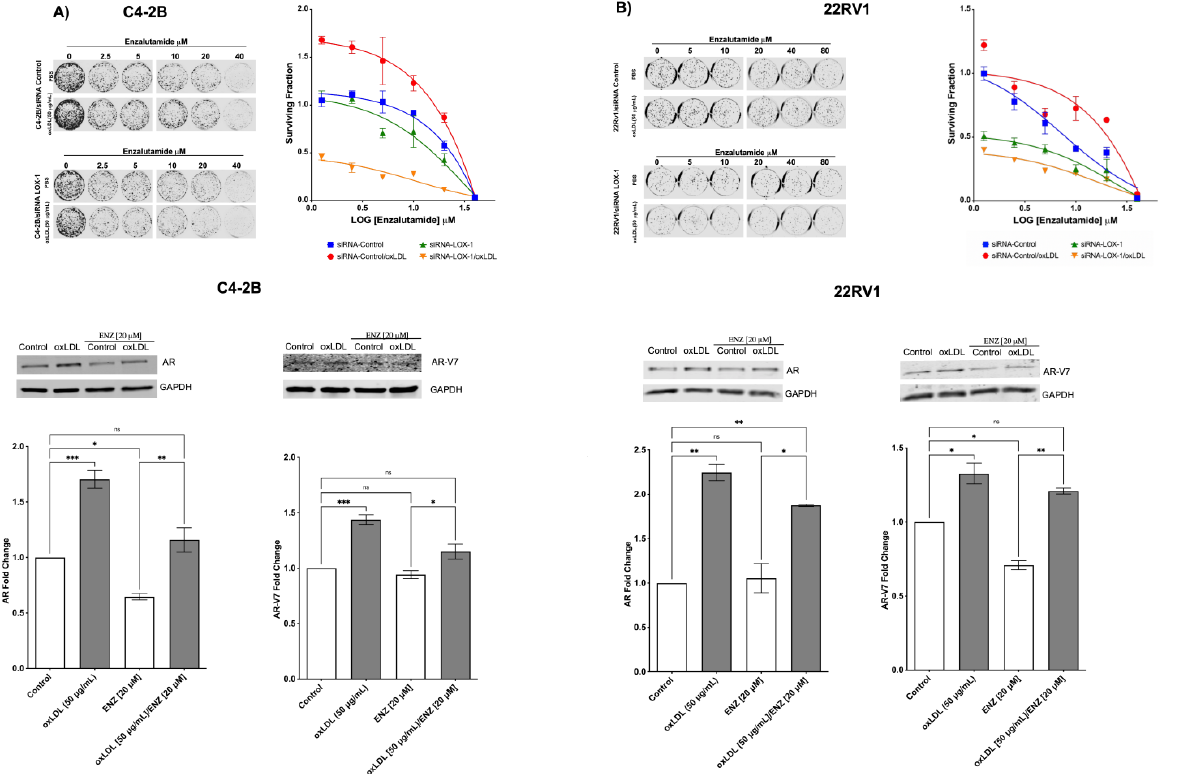
Figure 6. OxLDL/LOX-1 prevents the enzalutamide effects in CRPC cell lines. ( A ) clonogenic assay of C4-2B and 22Rv1 cells transfected with a siRNA against LOX-1 or siRNA control and co-treated with enzalutamide [0–40 µ M] and oxLDL 50 µ g/mL oxLDL. ( B ) oxLDL prevents the effects of enzalutamide on AR and AR-V7 expression in CRPC cell lines. Western blot analysis of AR and AR-V7 on C4-2B and 22Rv1 cells co-treated with enzalutamide [20 µ M]/oxLDL [50 µ g/mL]. The data represent the means ± S.D. of three independent experiments analyzed by one-way analysis of variance and Dunnett’s post-test. *** p ≤ 0.001, ** p ≤ 0.01, * p ≤ 0.05, ns: non-significant statistical